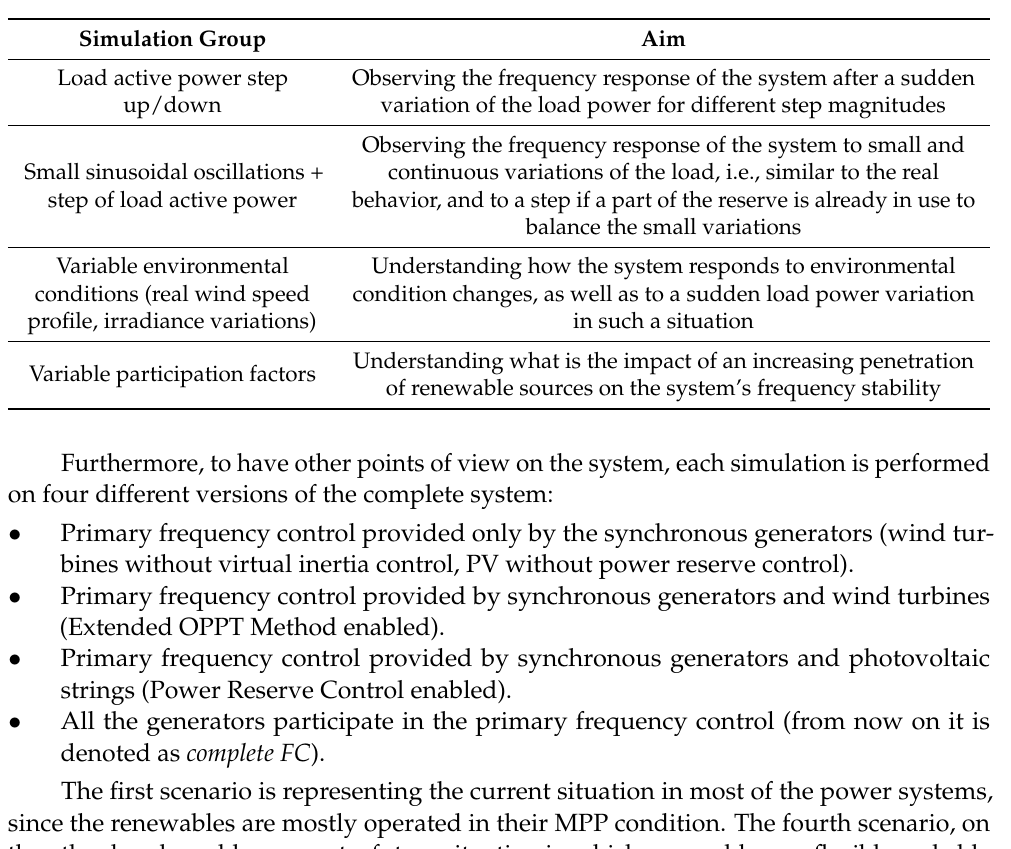
Table 2. Simulation groups and